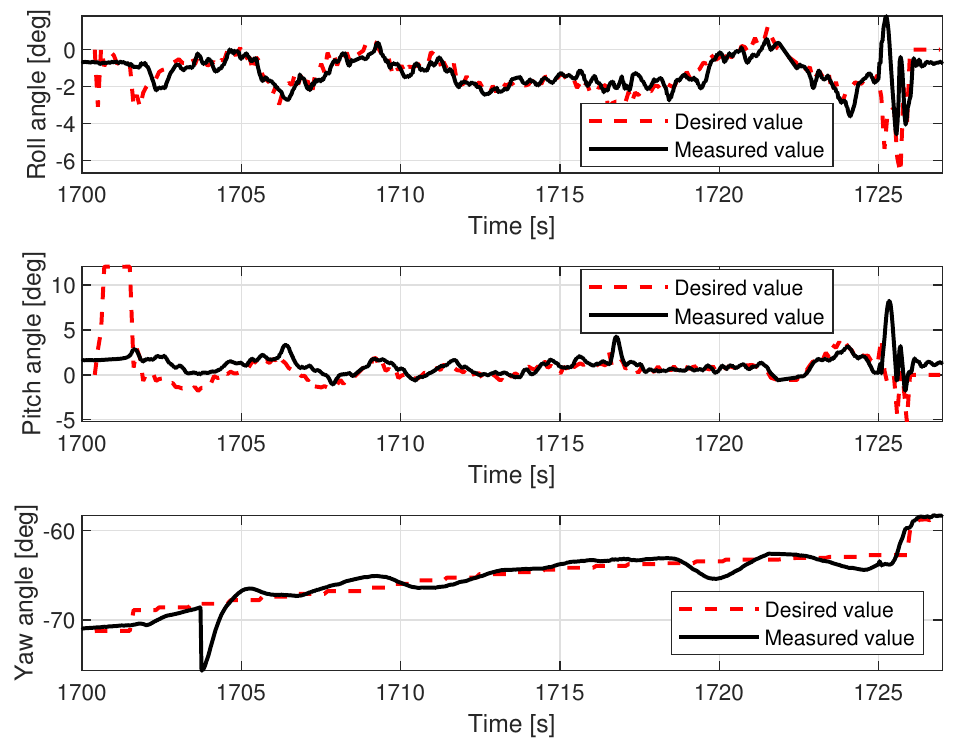
Figure 19. Multicopter roll, pitch, and yaw angles during the in-flight test.